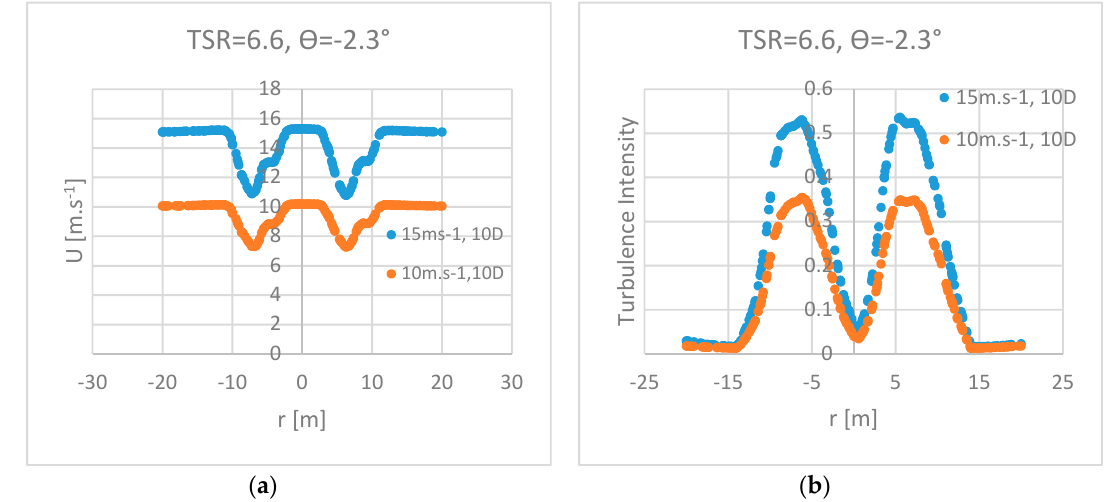
Figure 11. Influence of the free-stream velocity on the: ( a )velocity-deficit at 10D (diameters) downstream the rotor in the wake; and ( b ) TI at 10D (diameters) downstream the rotor in the wake.